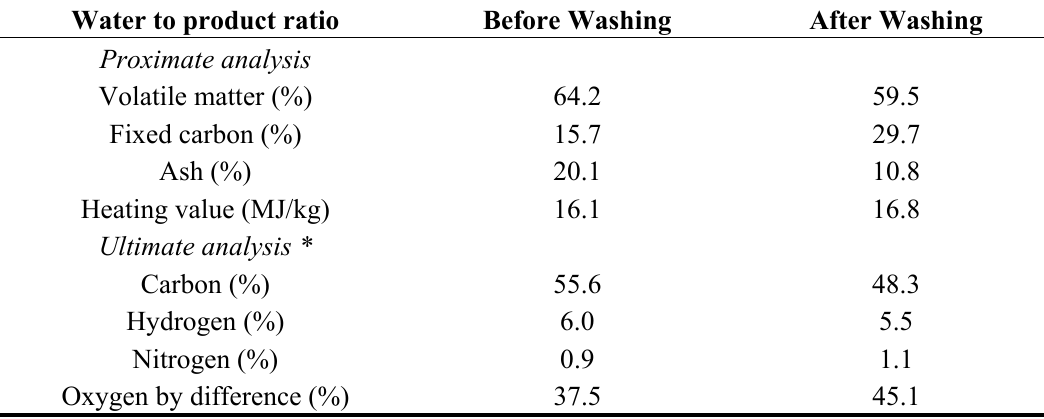
Table 1. Proximate and Ultimate Analysis of Hydrothermally Treated